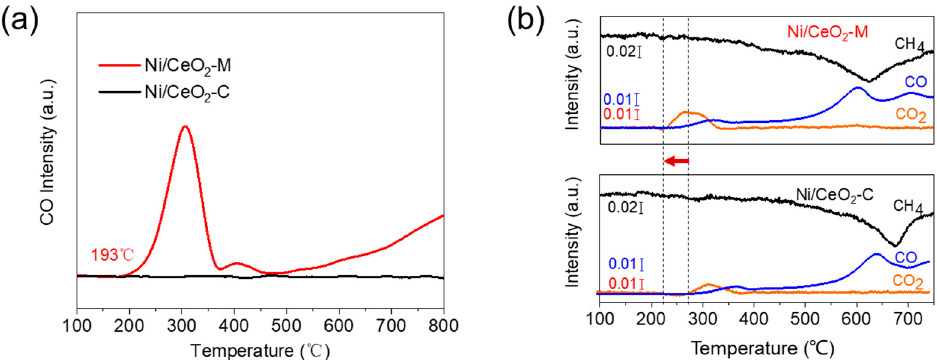
Figure 6. ( a ) CO 2 -TPSR profileand ( b ) CH 4 -TPSR profile of Ni/CeO 2 -C and Ni/CeO 2 -M catalysts.